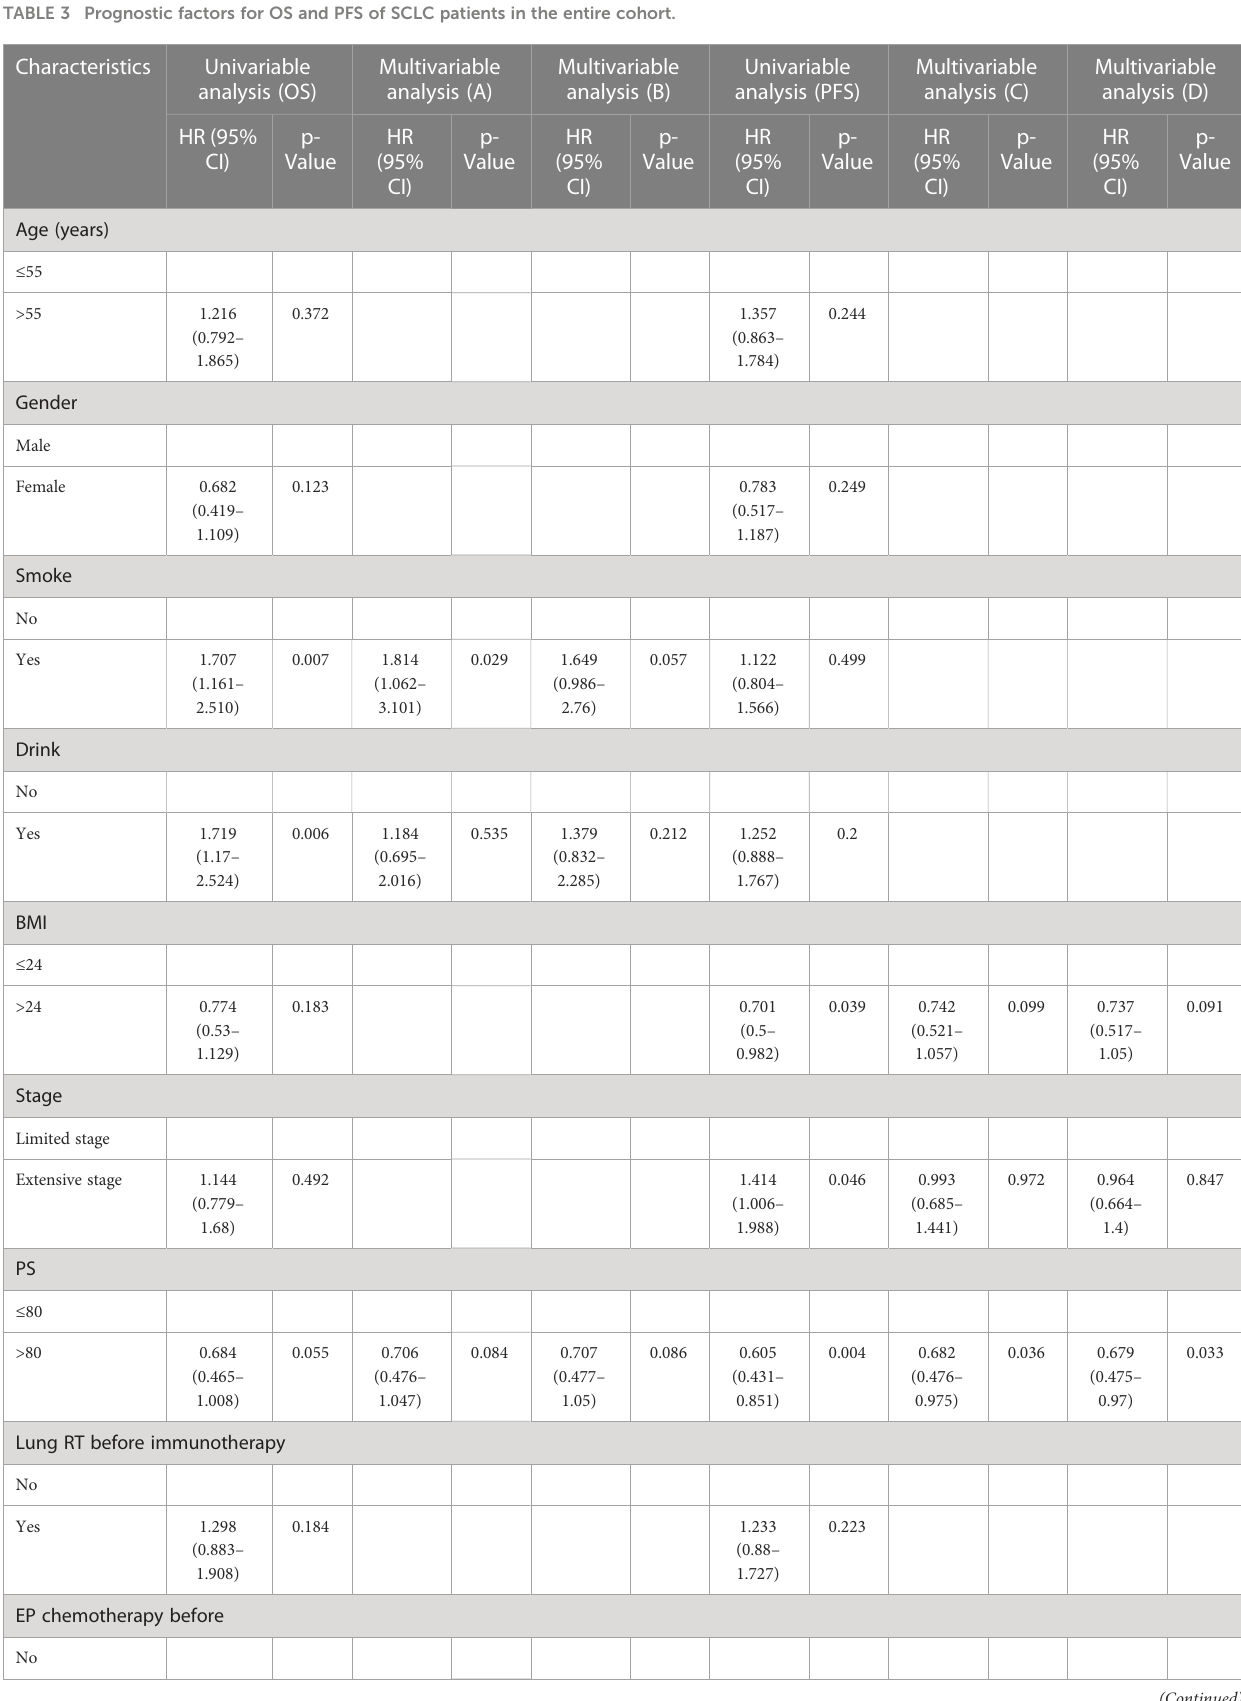
TABLE 3 Prognostic factors for OS and PFS of SCLC patients in the entire